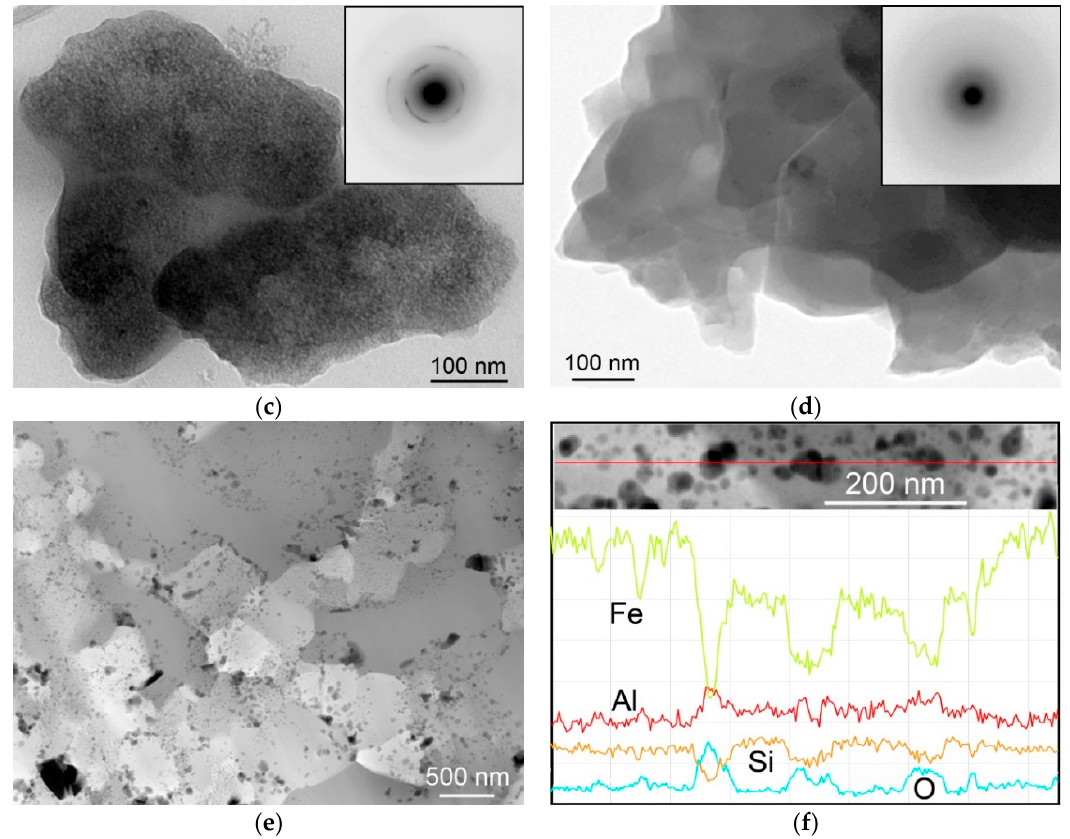
Figure 5. ( a – d ) Bright field TEM micrographs of: ( a ) nanocrystalline Fe 3 Si particles in the loose